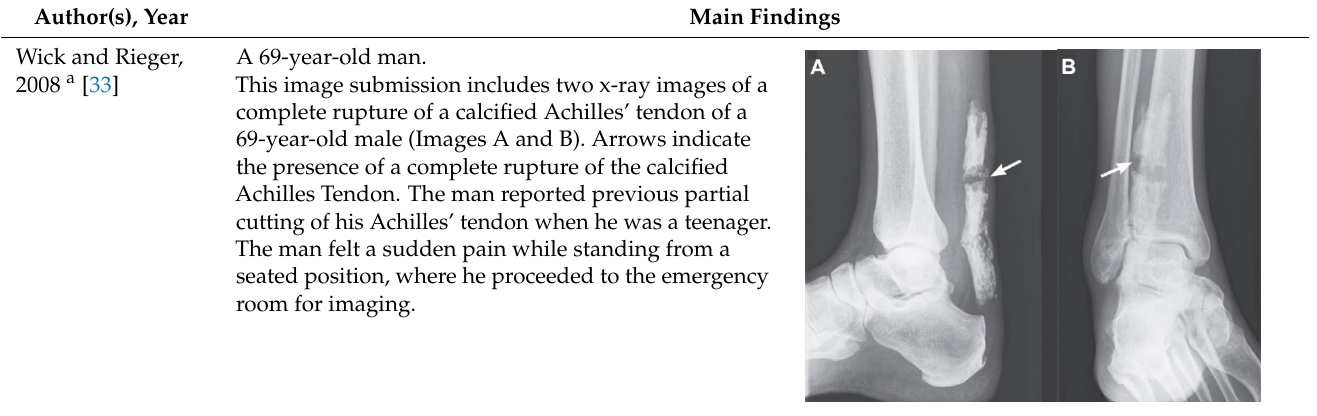
Table 2. Relevant articles (Clinical Images; 1990–2020) and their main findings.